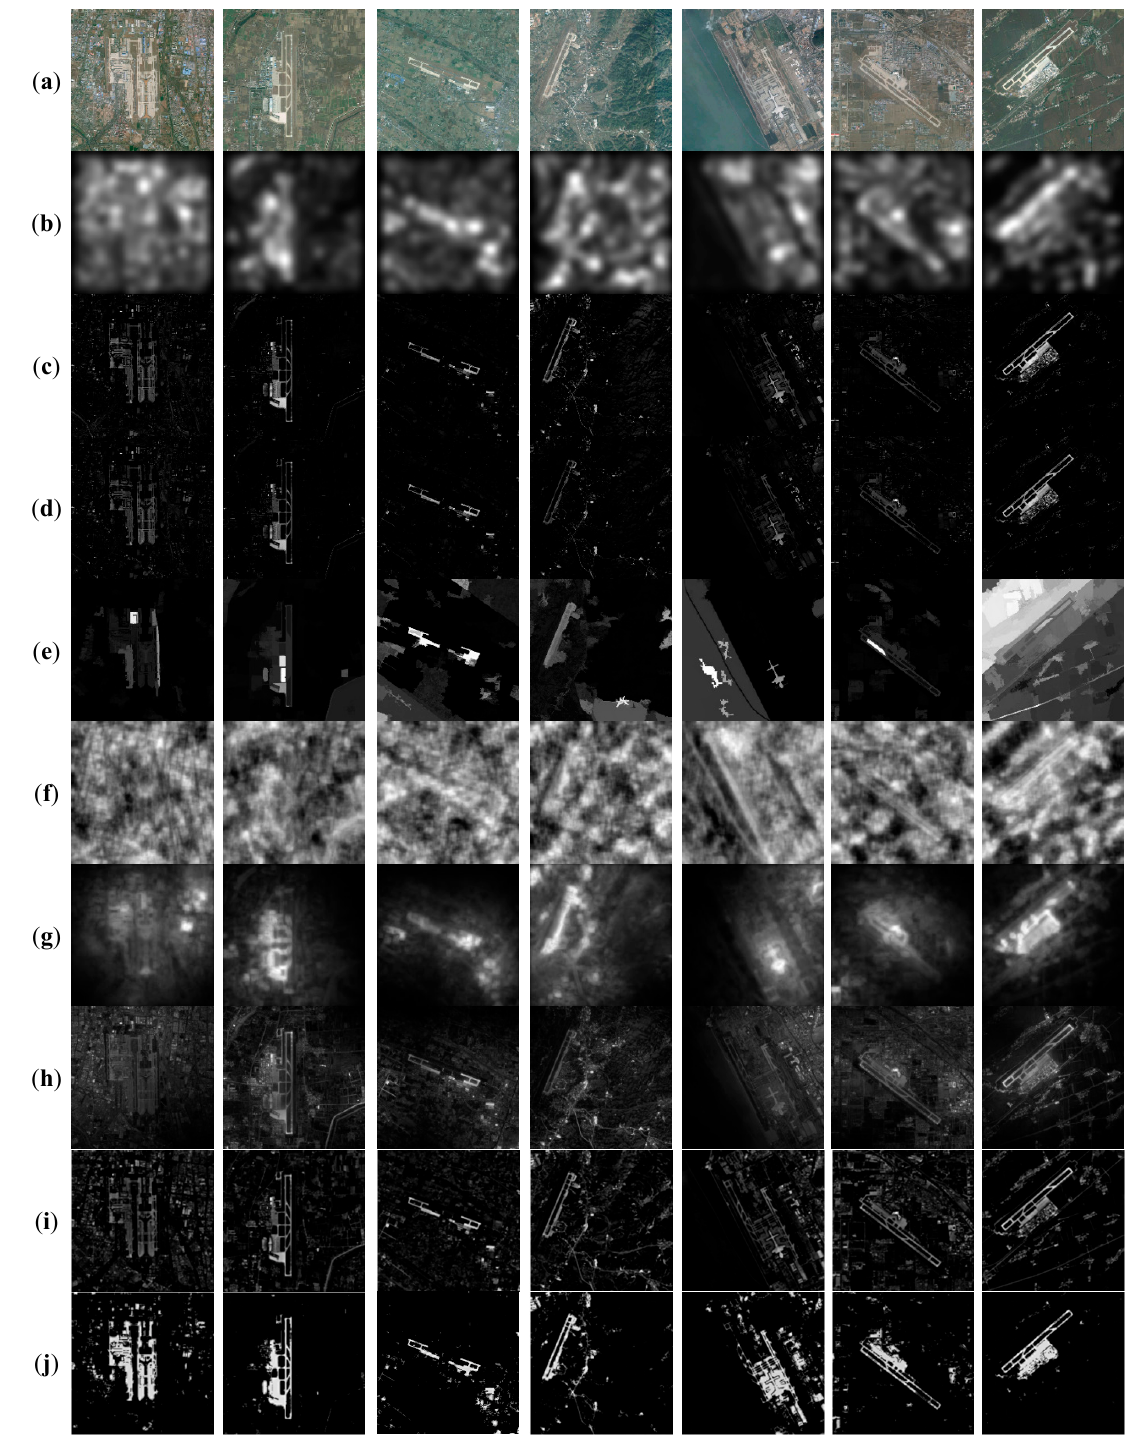
Figure 14. Visual comparison of saliency maps from Group Google Earth - Airport . From top to bottom are ( a ) input images; ( b ) ITTI; ( c ) FT; ( d ) MSSS; ( e ) CB, ( f ) SIM; ( g ) CA; ( h ) TMM; ( i ) FDA-SRD; and ( j ) our JMS model.